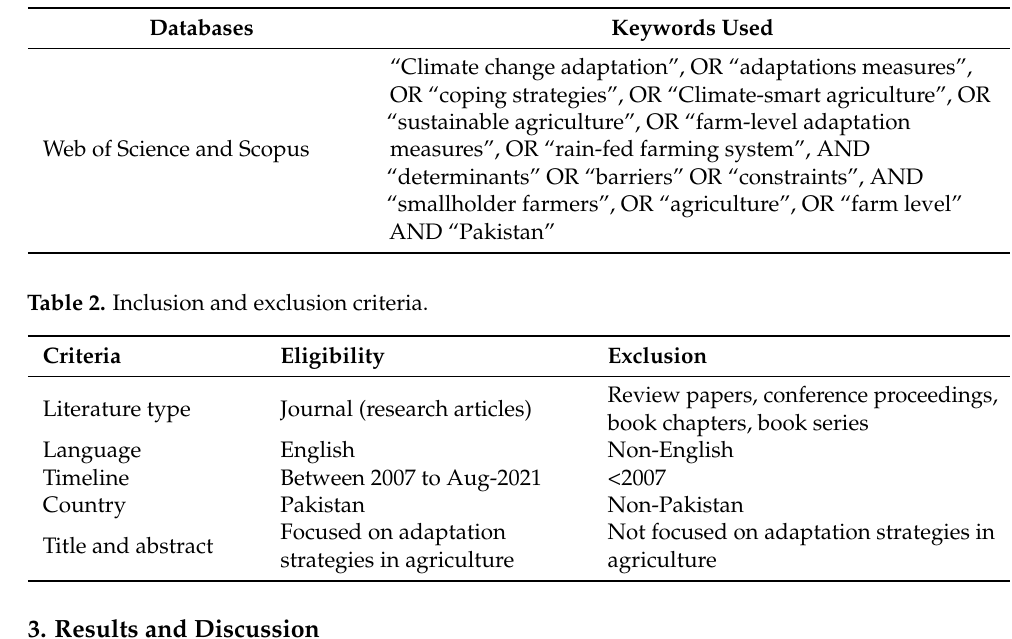
Table 1. Databases and keywords used.